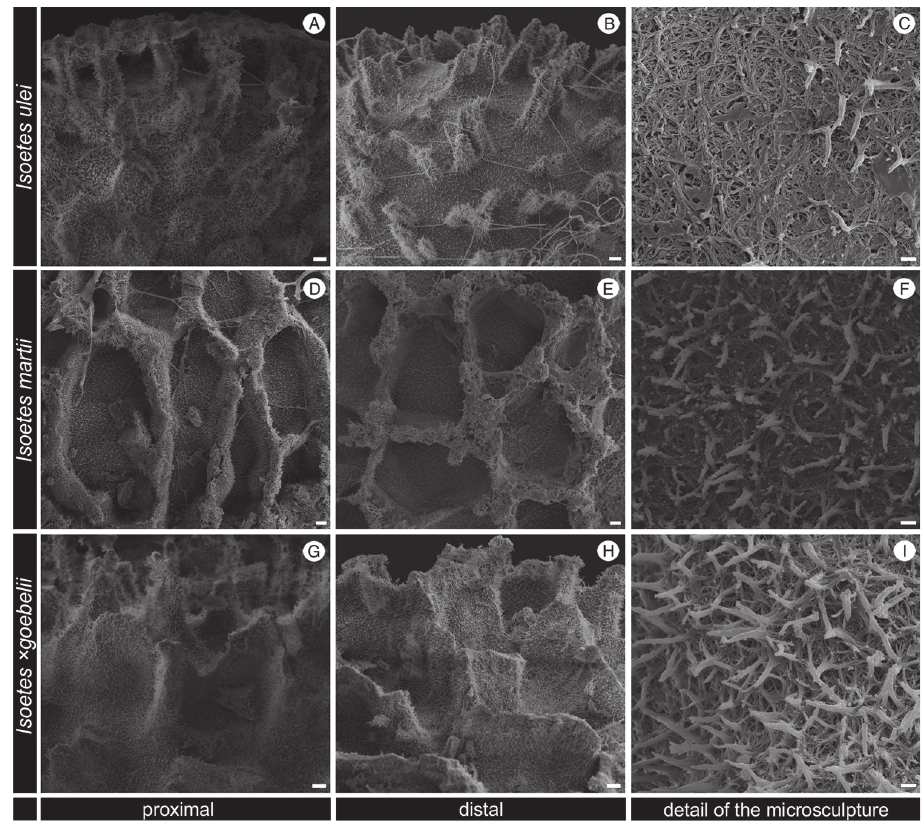
Figure 4. SEM images of the megaspore of Isoetes ulei (Ule 3533, HBG), I. martii (Pereira 726, UPCB) and I . ×g oebelii (Pereira 718, UPCB). A–B Details of the macrosculpture of the megaspore of I. ulei A Proximal view B Distal view C Details of the microsculpture of the megaspore of I.ulei in distal view showing the terminal ends of anastomosed bars joined forming echinulae D–E Details of the macros- culpture of the megaspore of martii D Proximal view. E. Distal view F Details of the microsculpture of the megaspore of martii in distal view showing the terminal ends of anastomosed bars joined forming echinulae G–H Details of the macrosculpture of the megaspore of I. ×goebelii G Proximal view H Distal view I Details of the microsculpture of the megaspore of I. ×goebelii in distal view showing the terminal ends of anastomosed bars joined forming echinulae. Scale bars: A, B, D, E, G, H = 10 µm; C, F, I = 1